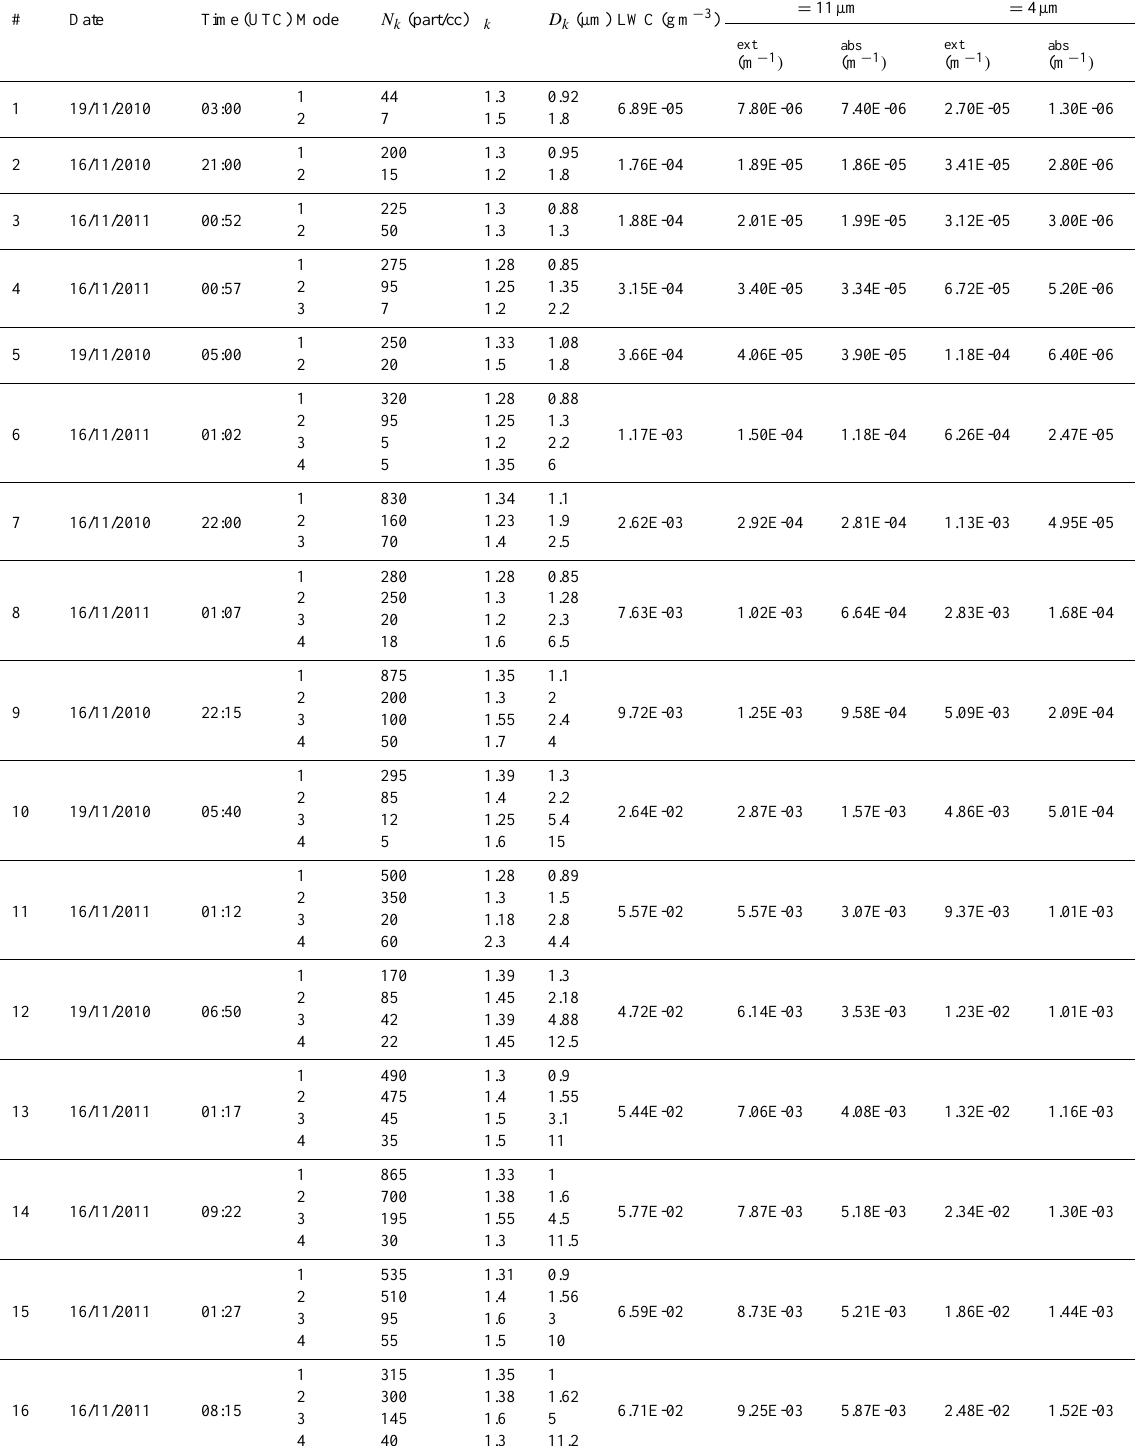
Table 1. Log-normal mode characteristics of the 20 fog size distributions used in this paper. D k is the modal diameter (equal to 2 r k )